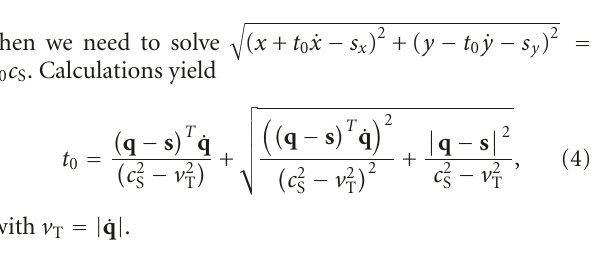
Figure 2: Bistatic setup; sound from source at s is reflected by the target at q and received at o . ϑ is the heading of the receiver relative to North.